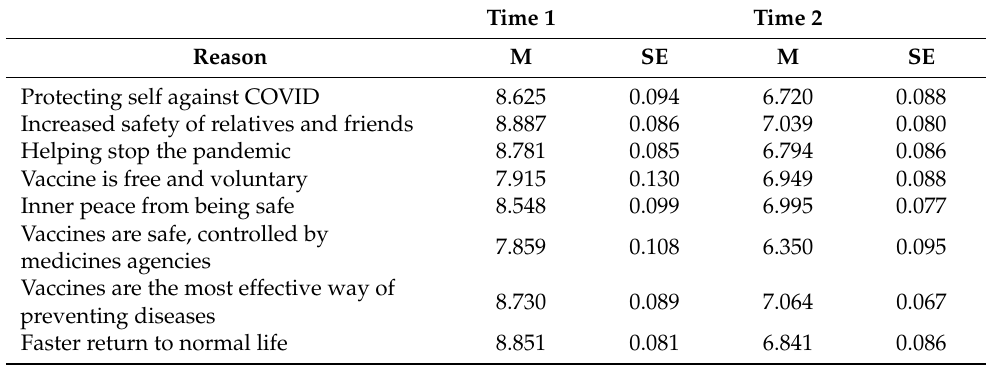
Table 3. Changes in reasons to vaccinate between Time 1 and Time 2 n consistently pro-vaccine individuals.